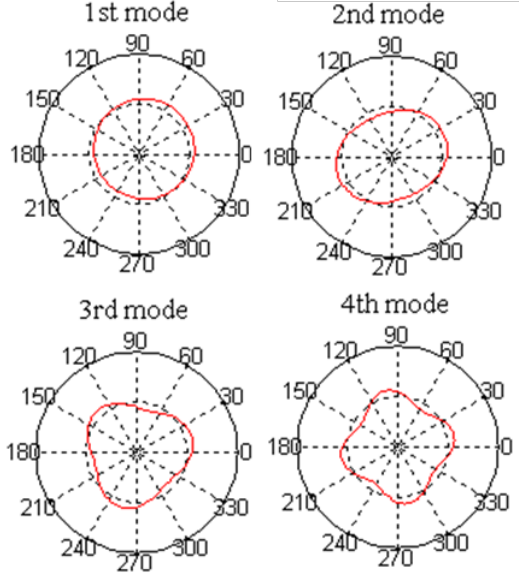
Figure 2. The first four natural modes (mode shape functions) of ring: The first mode is a rigid-body mode while the others are flexible